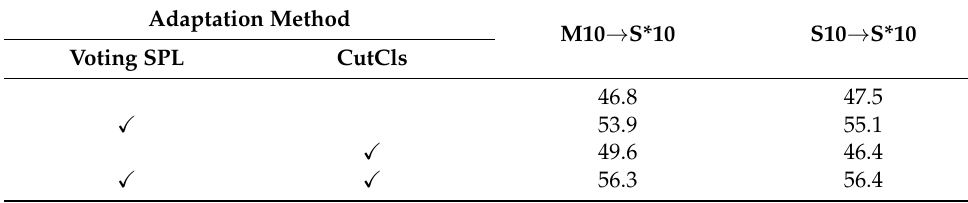
Table 2. Accuracy (%) of ablation study on M10 → S*10 and S10 → S*10 scenario. Adaptation Method